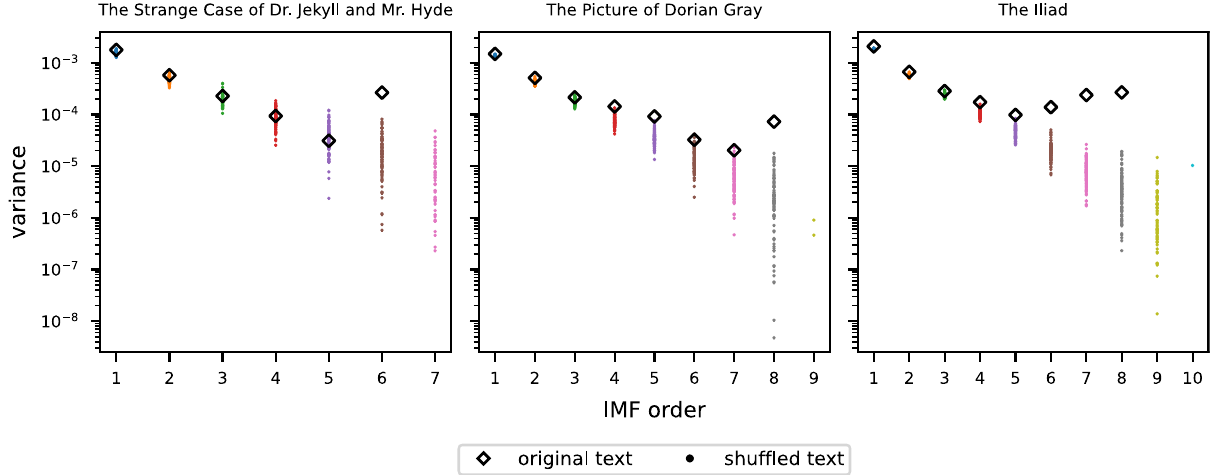
Fig. 4 A comparison of the variances of the IMFs for the original text and 100 different realizations of shuf fl ed text for three books in the dataset. Lower-order IMFs are more likely to correspond to noise, while higher-order IMFs are more likely to contain relevant information. Note that while technically the trend is not an IMF, for comparison purposes, the trend is included in this plot as the highest IMF order found for a given time series.